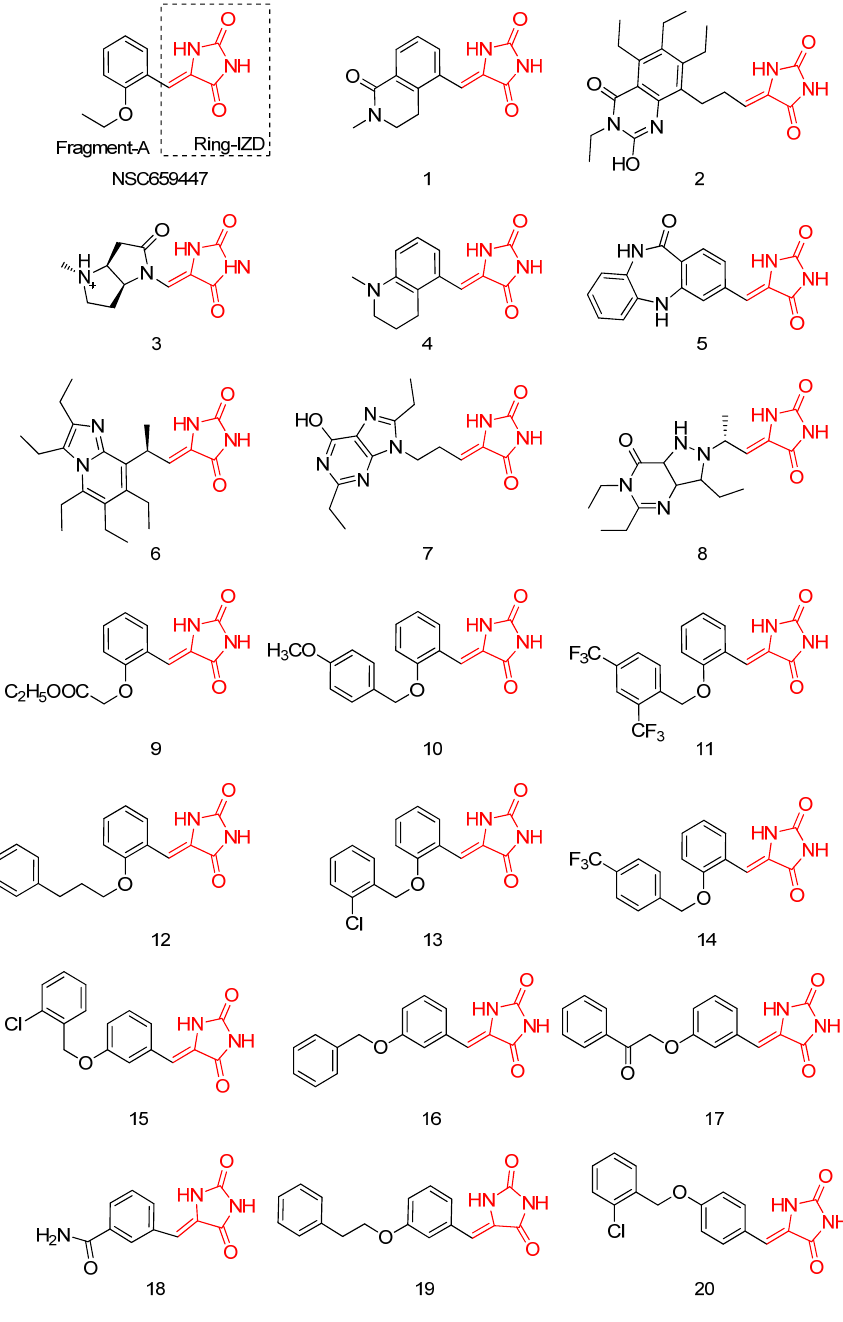
Figure 2. The top 20 derivative compounds offered by method of core-hopping. Ring-IZDs are colored in red; whereas Fragment-A is colored in black, which was replaced by package